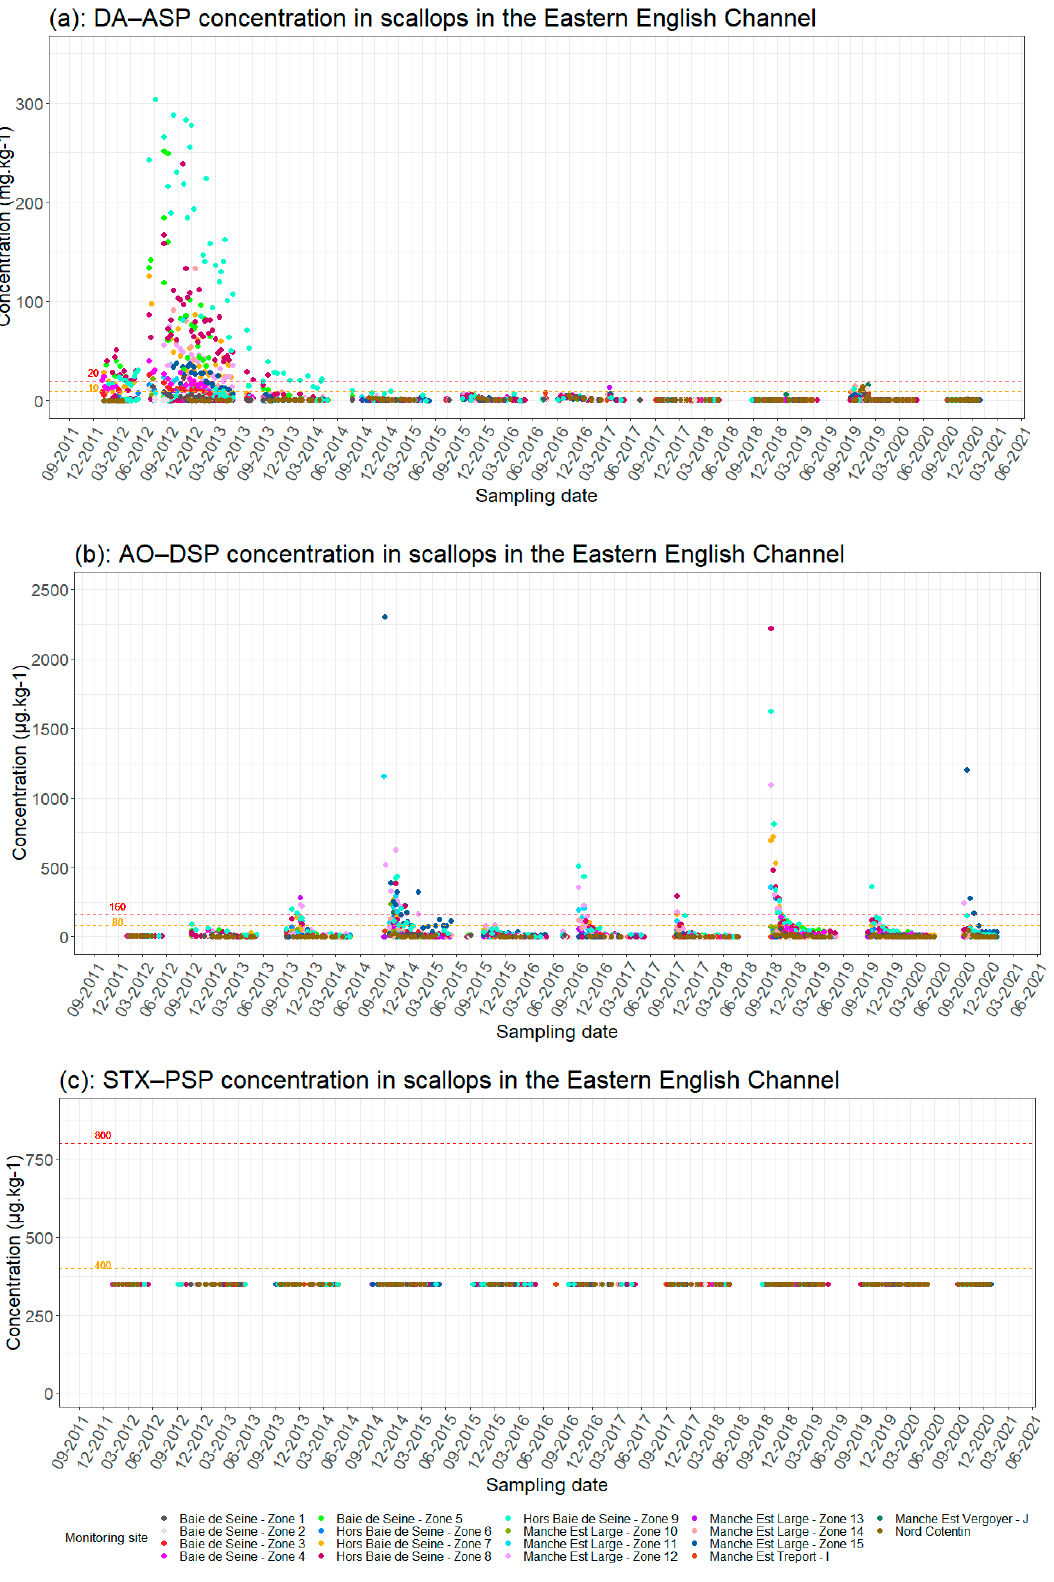
Figure 2. Changes in phycotoxin concentrations in scallops ( a ) [DA(Domoic Acid) − ASP, ( b ) OA(Okadaic Acid) − DSP and ( c ) SXT (Saxitoxins) − PSP] in scallops in the eastern Channel by production area (see Figure 1). Red dotted line = regulatory toxicity threshold; orange dotted line = half toxicity threshold.